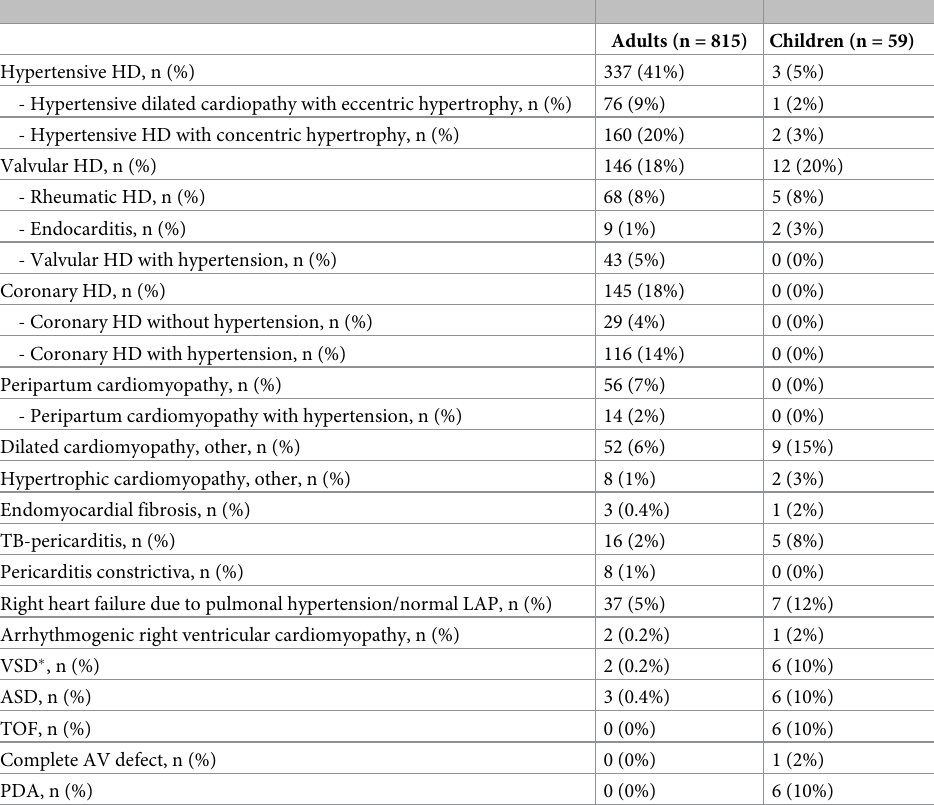
Table 3. Causes of heart disease in 874